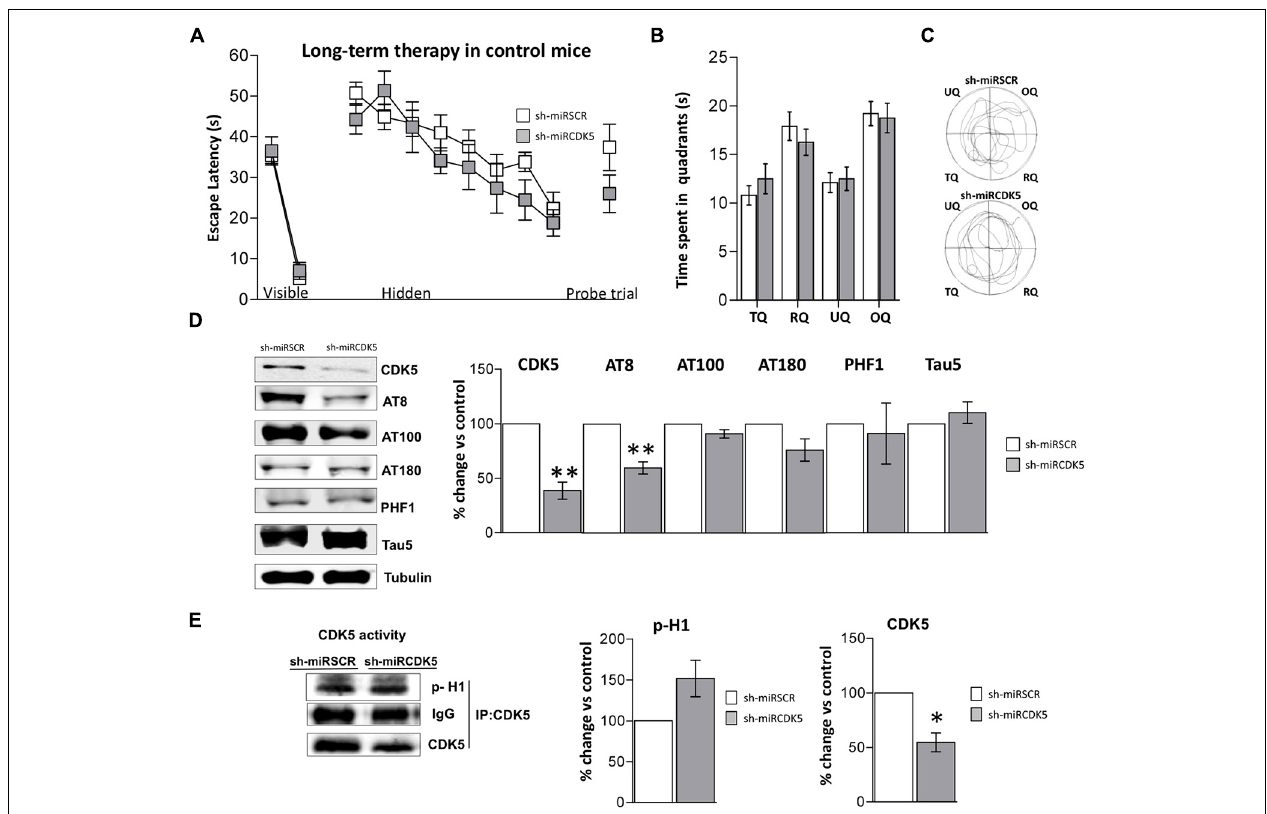
FIGURE 3 | Long-term treatment with CDK5 RNAi’s reduced phosphorylatedTau in control animals (littermates with only the PS1 M146V knock-in) but did not affect spatial memory. MorrisWater Maze (MWM) testing was performed in 18-month-old control mice 1 year after injection with shSCRmiR (white squares) and shCDK5miR (gray squares). (A) Values of latency to reach the visible and hidden platform during training and probe trial tests 48 h after training. (B) Time spent in the target quadrant and (C) path plots for the median path length during the probe trial. (TQ = target quadrant, RQ = right quadrant, UQ = upper quadrant and OQ = oppositive quadrant.) Data are presented as mean ± SEM. n = 10 by each group.